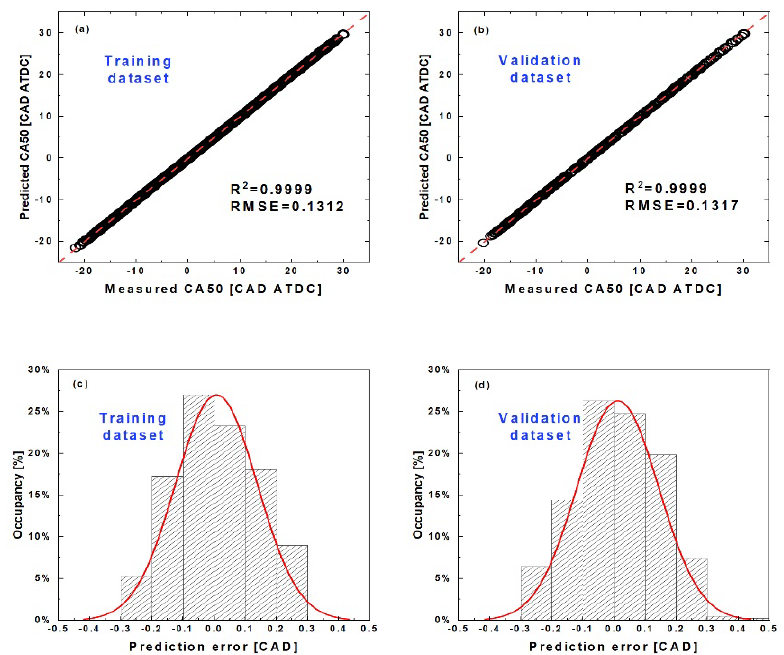
Figure 8. Comparison of predicted CA50 with the measured data. ( a ) Prediction performance of training dataset; ( b ) prediction performance of validation dataset; ( c ) prediction error of training dataset; and ( d ) prediction error of validation.